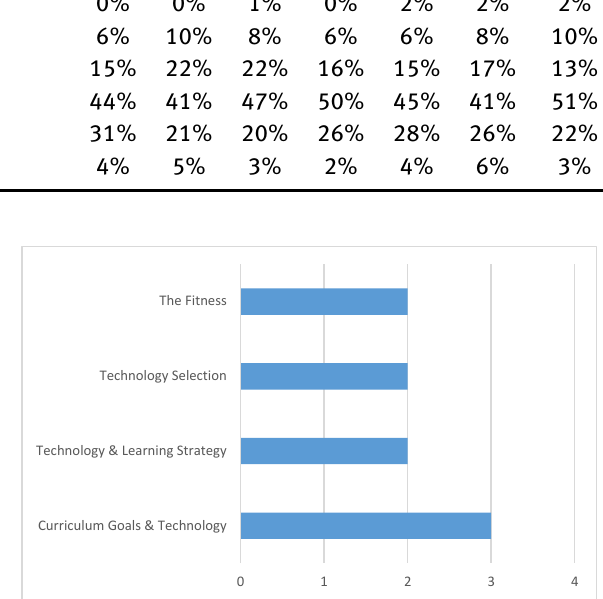
Table 1: The percentage of secondary vocational teachers regarding TPVK Point